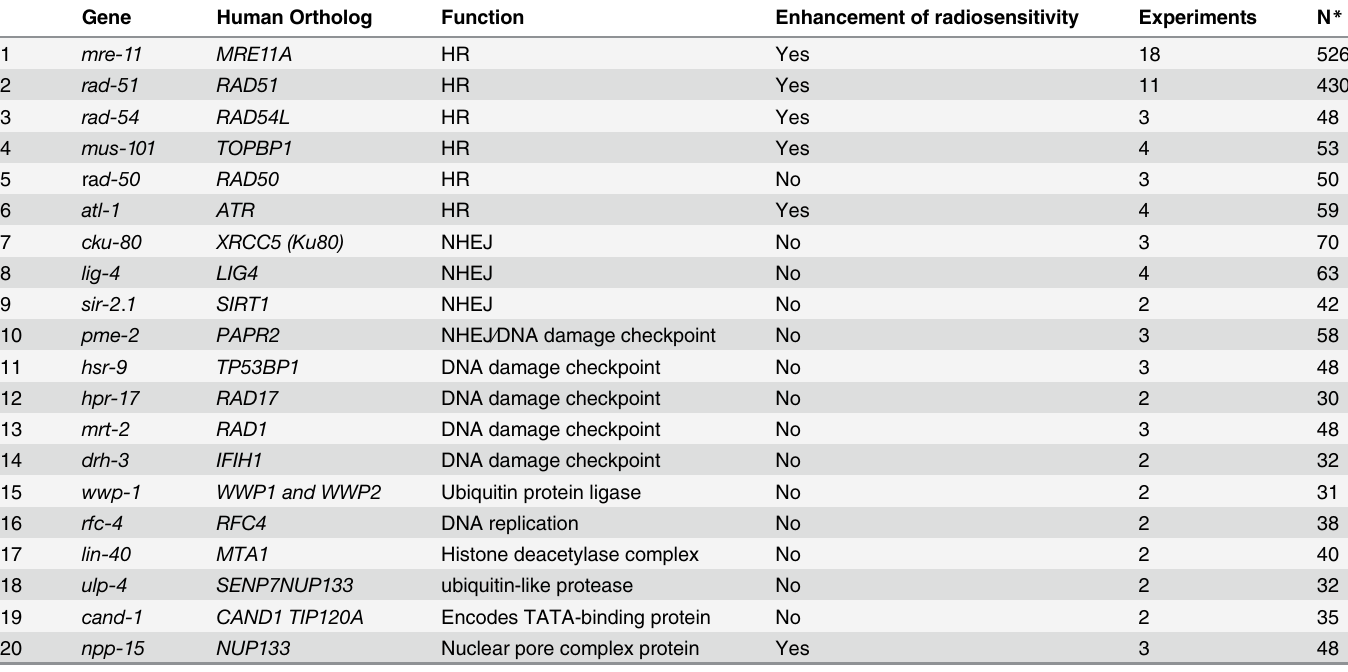
much higher levels than animals grown at the restrictive temperature, which lack a germ line. Gene expression levels in somatic tissue and germ line could also be affected by culturing ani- mals at the different temperatures, although this is unlikely in our study. We conclude, there- fore that NHEJ genes are, in fact, enriched in the germ line, while post-mitotic somatic cells in adult worms express minimal amounts. Consistent with these data, we recently reported mitot- ically-active cells of murine small intestinal crypts aggressively repair radiation DNA damage, while post-mitotic villus cells do not [23]. To obtain functional evidence that RNAi feeding adequately inactivated respective NHEJ DSB repair genes, we examined consequence of inactivating NHEJ genes on somatic develop- ment in irradiated wild-type worms. For these studies, N2 embryos grown in lig-4 RNAi plates were collected at 4h post egg laying, a time preceding vulval development, and irradiated with 120Gy. At 96h after 120Gy, minimal overall damage was detected in N2 worms even with rad- 51 silencing, while lig-4 or cku-80 knockdown-worms displayed abnormal vulval development (Fig 3F, upper panel, p < 0.01 for lig-4; p < 0.05 for cku-80 ), with increased penetrance of somatic defects (lower panel) [47,48]. Taken together, our results suggest that failure of germline tumors to use NHEJ to repair radiation-induced DSBs results from lack of engagement of NHEJ repair machinery, rather than lack of availability of NHEJ repair genes in the germline. Table 1. RNAi of DDR orthologs detects genes that enhance ar202 tumor radiosensitivity. Gene Human Ortholog Function Enhancement of radiosensitivity